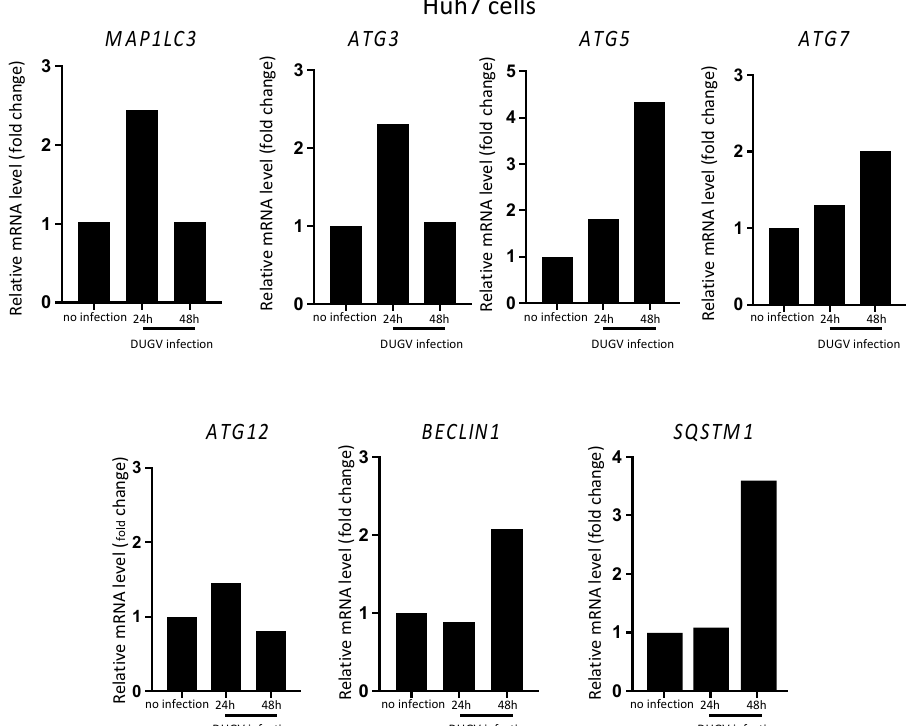
Figure 2. Profile of some autophagy-related gene expression during Huh7 cell infection with DUGV. Transcripts of MAP1LC3A/B , ATG3 , ATG5 , ATG7 , ATG12 , BECLIN1 , and SQSTM1 autophagy genes were quantified by RT-qPCR using total RNA from DUGV-infected Huh7 cells (MOI 0.01) at 0 (no infection), 24, and 48 h after infection. The house-keeping genes used were GAPDH , and ACTB . Fold changes in the mRNA level were calculated after deriving ∆∆ Ct and normalized to that of non-infected cells (mean of two independent